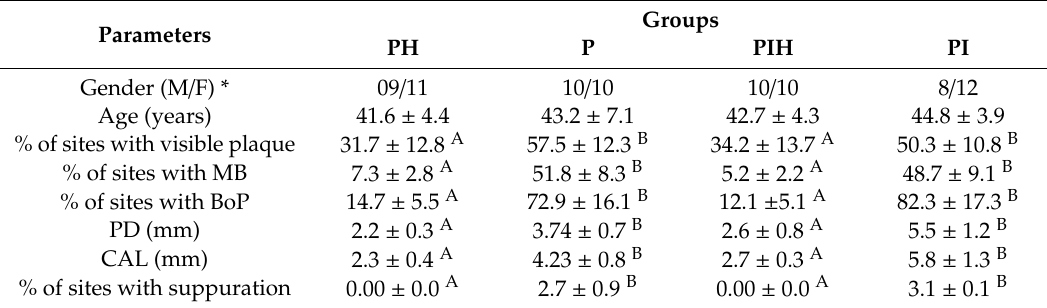
Table 2. Demographic characteristics and mean periodontal clinical parameters ( ± SD) of the study population.